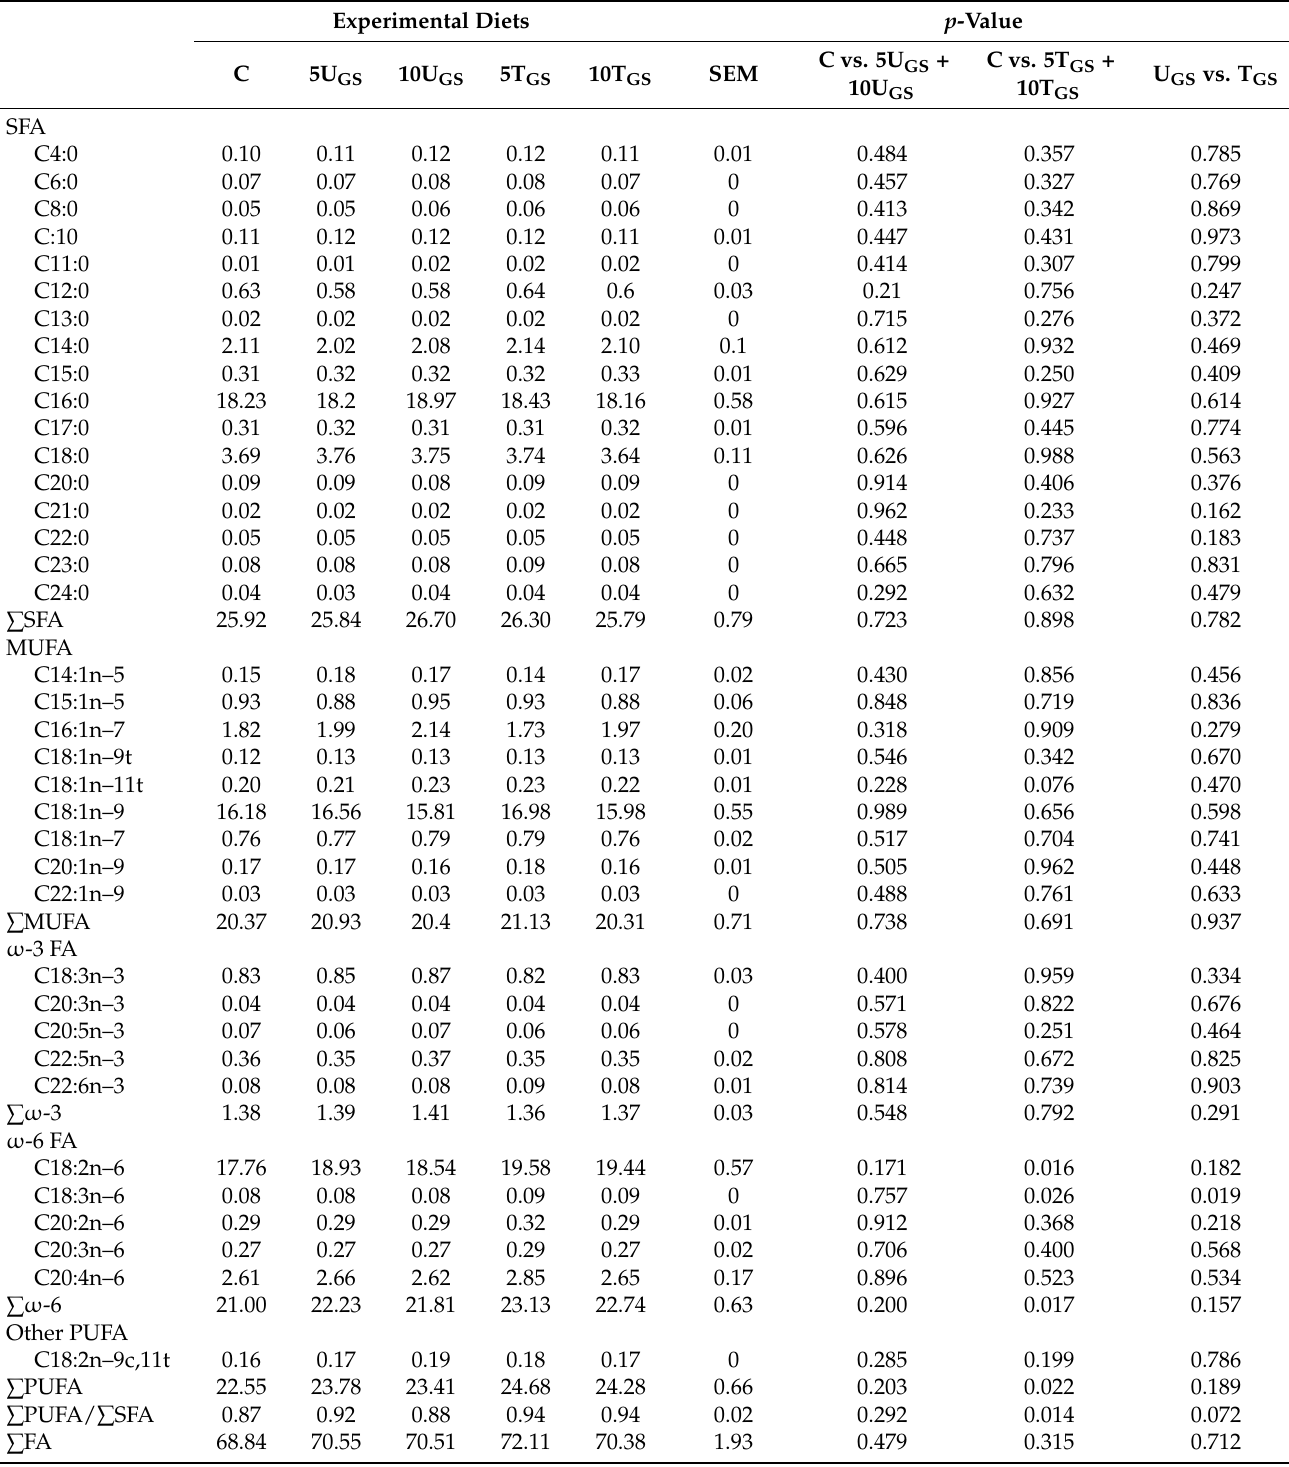
Table 6. Effect of the experimental diets on fatty acids profile of longissimus muscle (g/100 g of fat; n =